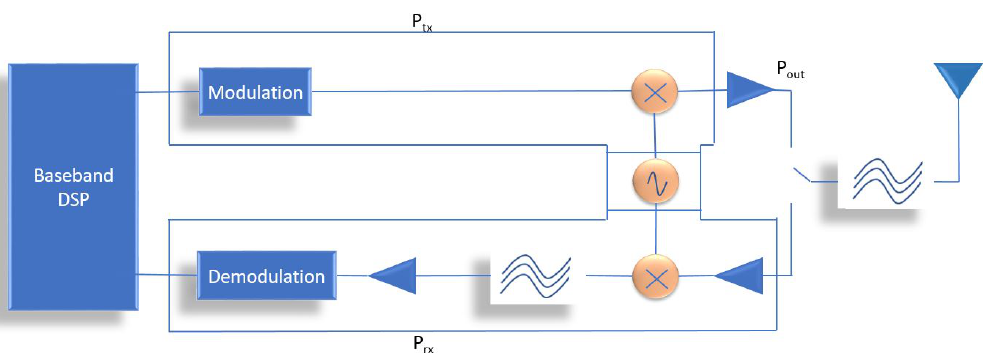
Figure 10. Radio model [60].